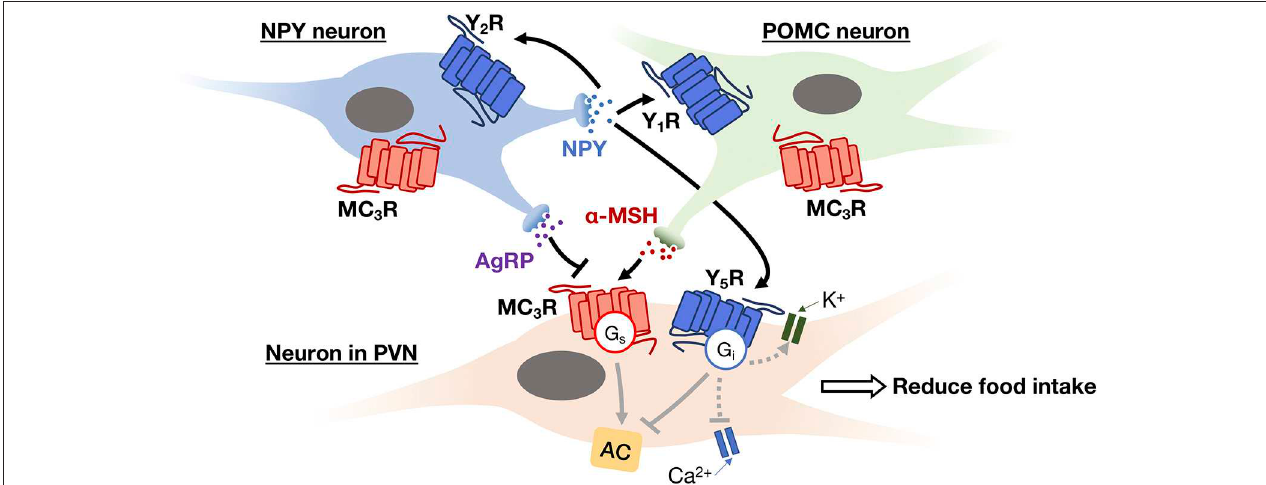
FIGURE 3 | An example of autocrine and paracrine interactions between NPY neuron (blue) and POMC neuron (green) in the ARC and their downstream effector neuron (i.e., neuron in PVN; beige). NPY secreted by NPY neuron can trigger G i signaling pathway to inhibit Ca 2 + channel activity and activate GIRK current via its receptors (Y 1 R, Y 2 R, and Y 5 R) in both autocrine and paracrine manners, thereby inhibiting the release of neurotransmitters. While AgRP and α -MSH secreted by NPY neuron and POMC neuron, respectively, act as antagonist and agonist of MC 3 R. The activation of MC 3 R can reduce food intake via the feeding circuit in the